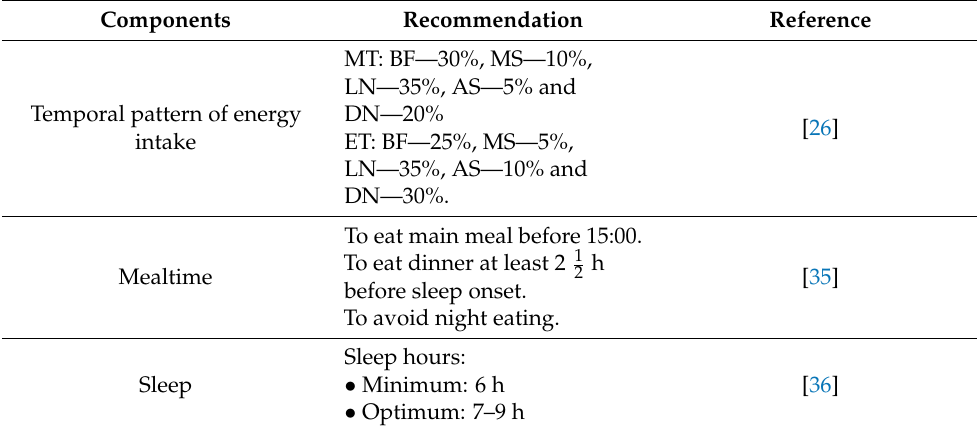
Table 1. Proposed recommendations for chrono-nutrition